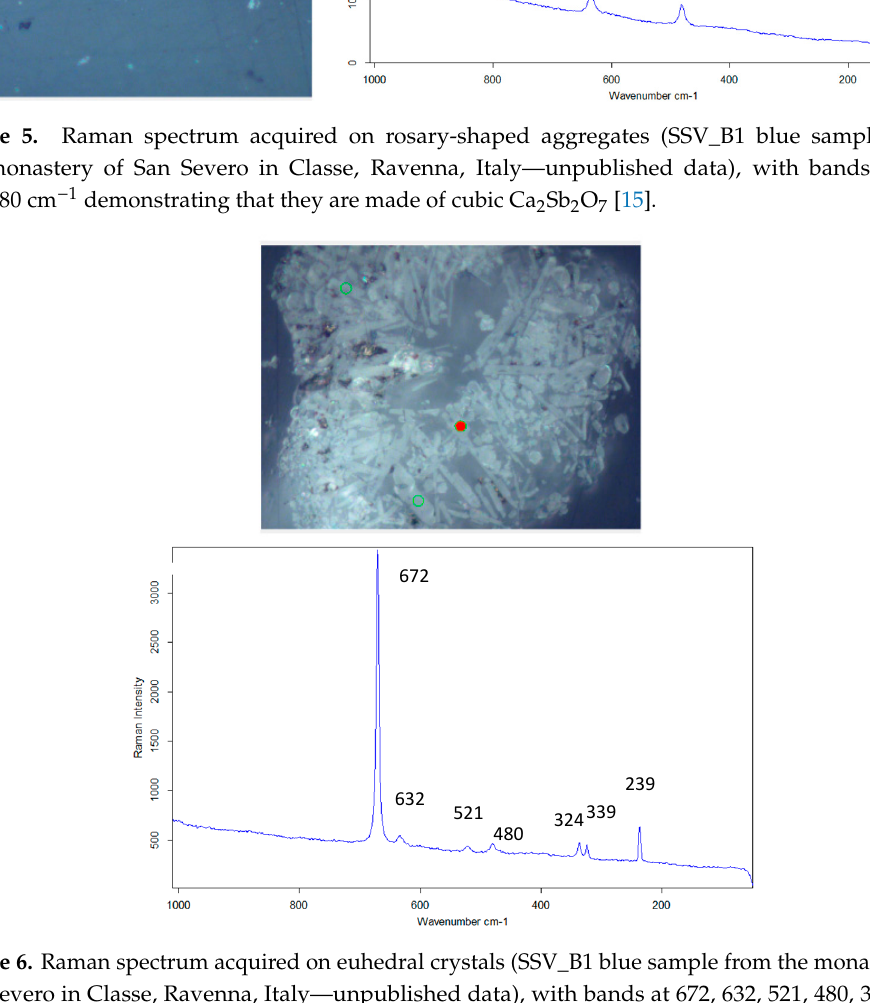
Severo in Classe, Ravenna, Italy—unpublished data), with bands at 672, 632, 521, 480, 339, 324, and 239 cm -1